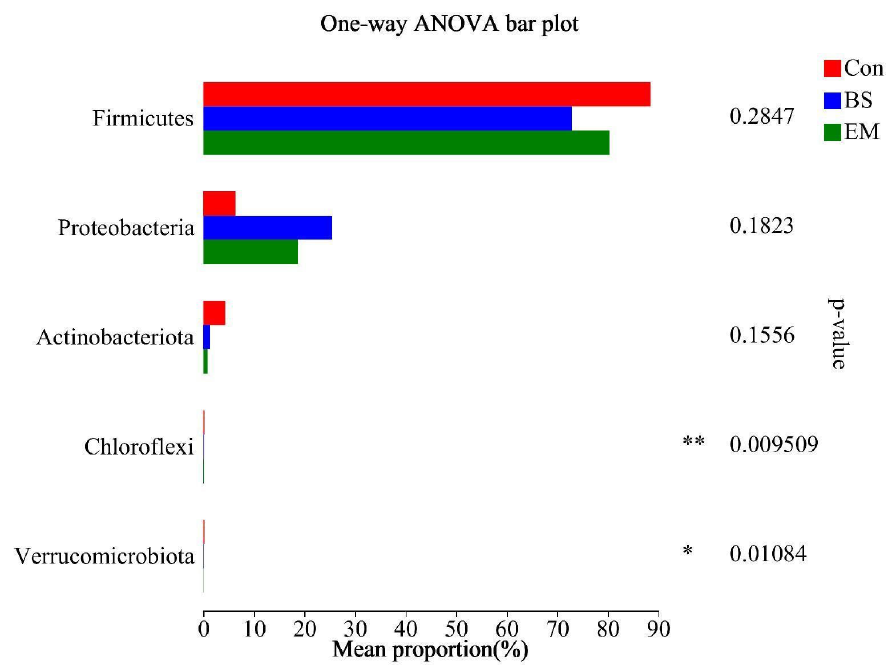
Figure 3. Analysis of signi fi cant di ff erences in the dominant fl ora of the intestinal tract of M. rosen- bergii at the phylum level. Signi fi cance ( p < 0.05) indicated by *. Signi fi cance ( p < 0.01) indicated by